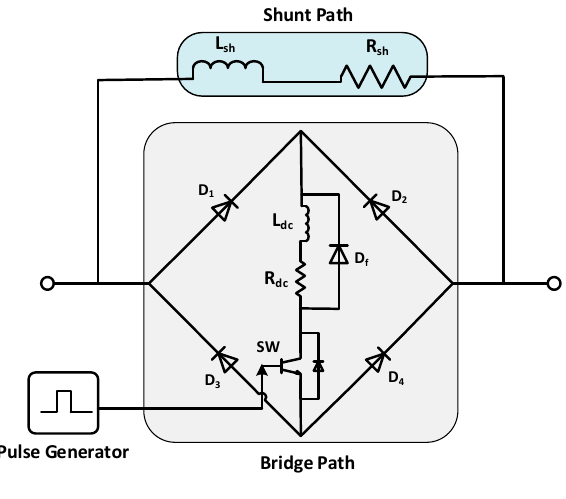
Figure 6. Crowbar circuit with controlled switches. 2.5.2.2. Bridge-Type Fault Current Limiters (BFCL) The BFCL strategy for LVRT enhancement of rotating units like doubly fed induction generator (DFIG) has been proposed [40]. To analyze and investigate the response of BFCL for grid-connected PVS to enhance its LVRT capability for the grid requirement is proposed here. The fault currents are optimized to rated values without compromising at ripples by the BFCL strategy through its dual path control. The BFCL strategy is comprised of two paths i.e., bridge path and shunt path [41]. The bridge path using the current in normal conditions, which consists of four diodes (D 1 -D 4 ) connected to pass